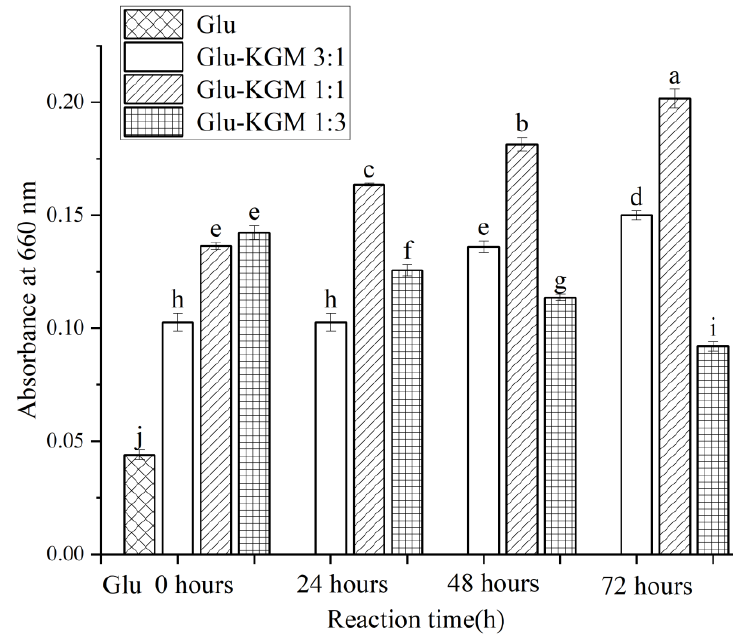
Figure 4. Turbidity diagram of gluten, mixtures, and conjugates, respectively. The results with dif- ferent letters were significantly different ( p <